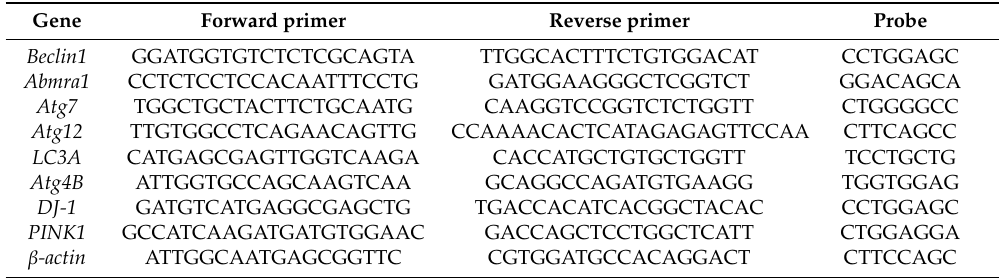
Table 1. Primer and probe sequences of real-time quantitative